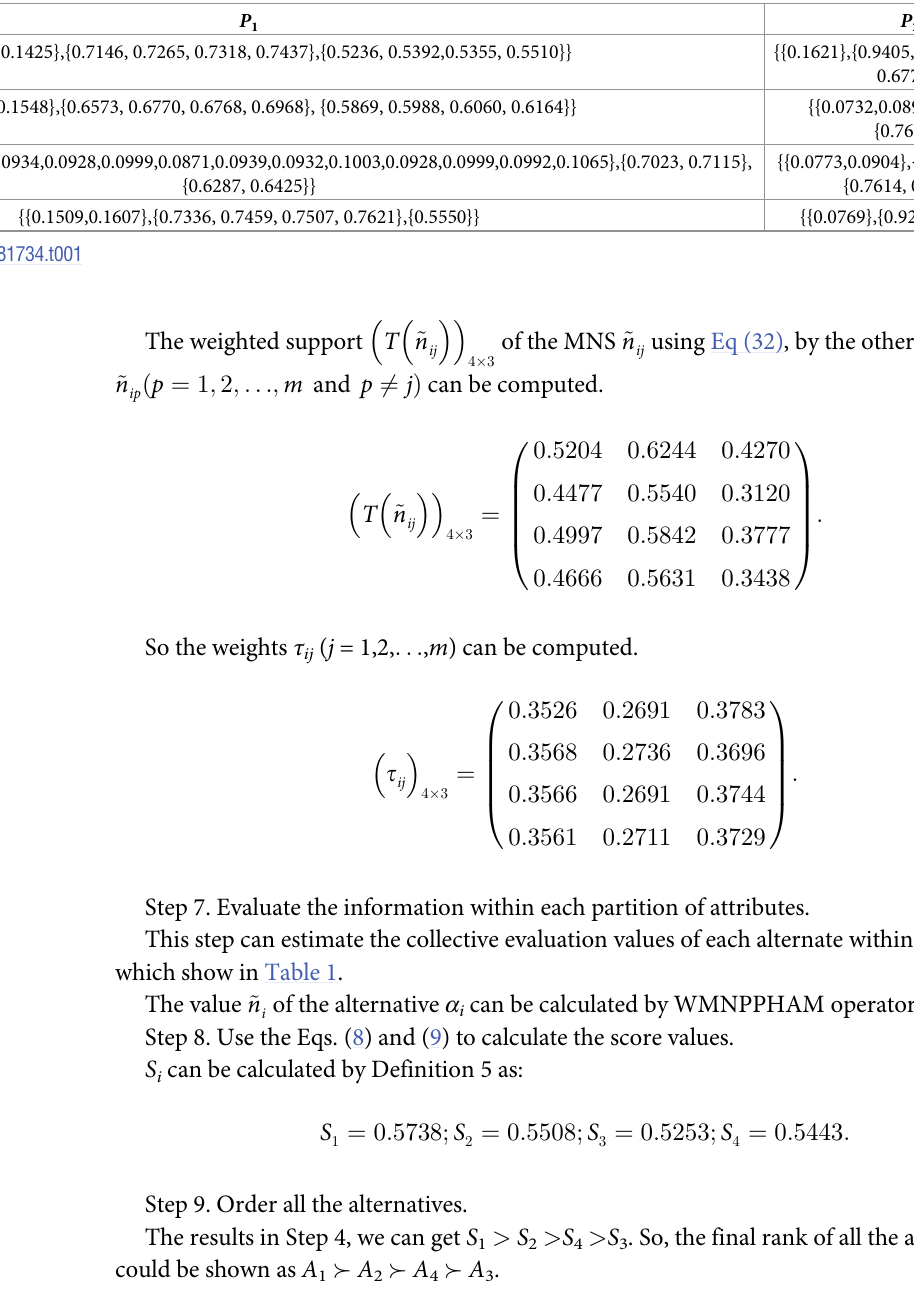
Table 2. The comprehensive value of the